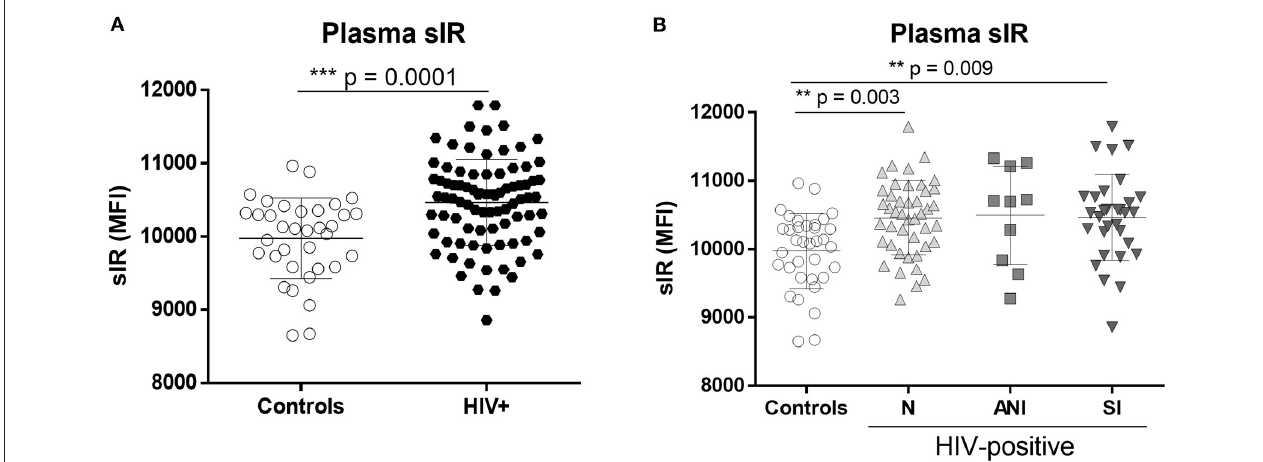
FIGURE 1 | Levels of the soluble insulin receptor in plasma of control and HIV-infected women. sIR was measured in the plasma of HIV-negative (controls n = 35) and HIV-infected ( n = 86) women by flow cytometry (A) . HIV-infected women were stratified by HAND status as normal cognition (N) ( n = 44), asymptomatic cognitive impaired (ANI) ( n = 10), and symptomatic impaired (SI; MND and HAD) ( n = 32) (B) . Graphs show mean and standard deviation [Controls (9,975 ± 549.2), N (10,459 ± 541.6), ANI (10,497 ± 718.7) and SI (10,464 ± 630.8)] results were graphed as mean fluorescence intensity (MFI) units. Analysis was performed using the Unpaired t -test and Kruskal–Wallis test with Dunn’s multiple comparisons.